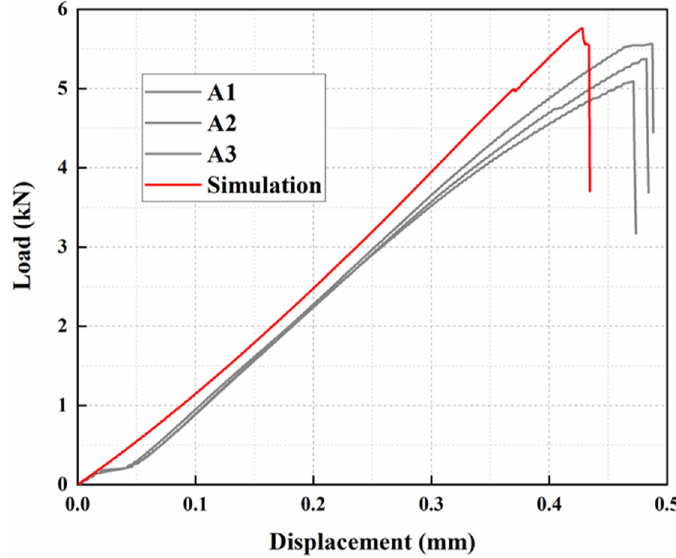
Figure 7. Comparison of experimental and FE simulation results.